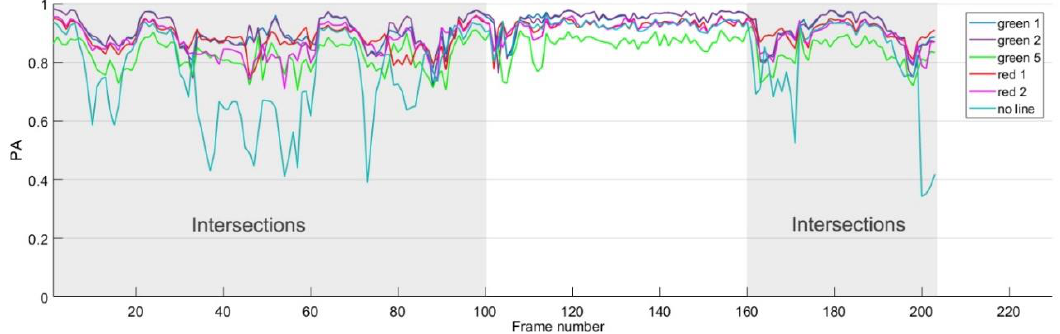
Figure 7. PA of detection for each frame.